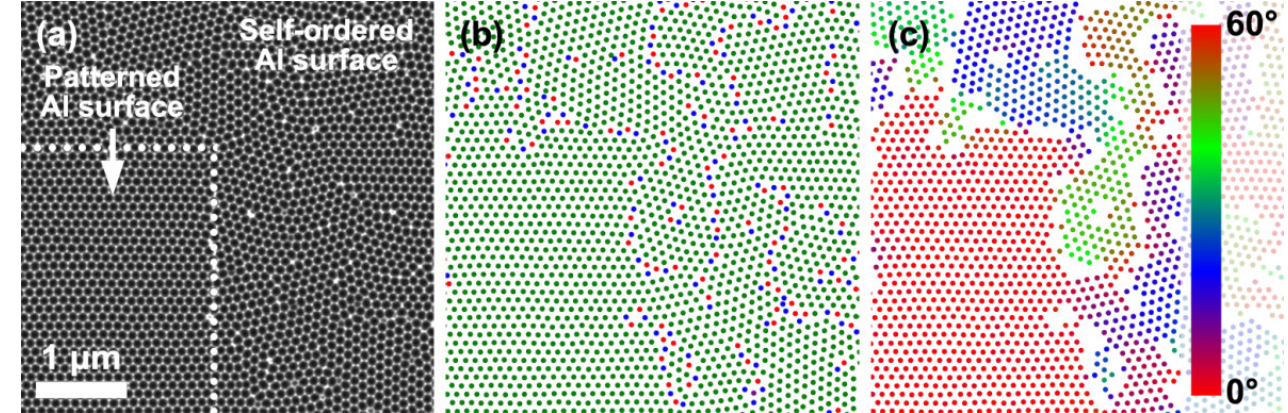
Figure 2. Color coding of SEM data. ( a ) SEM image and ( b , c ) corresponding color-coded maps, where the colors indicate the following: ( b ) the number of the nearest neighbors (five—red, six—green, and seven—blue) and ( c ) azimuthal orientation of hexagons formed by the nearest neighbors of the considered pore reduced into a basic angle interval of [0 ◦ , 60 ◦ ]. The horizontal direction is used as a reference azimuthal direction.